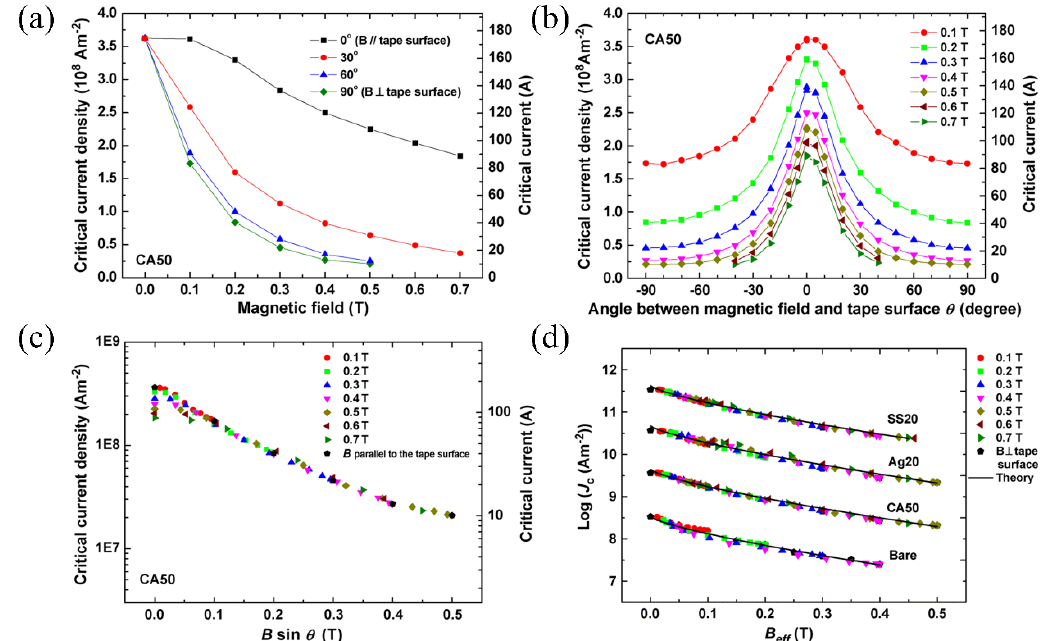
Figure 6. The electrical transport properties of the BSCCO tape at 77 K. ( a ) J c vs. B for different field orientations. ( b ) J c vs. θ at different applied magnetic fields. ( c ) I c vs. B sin θ of the tape. ( d ) J c vs. B eff for different tapes at 77 K. Reprinted with permission from Ref. [59]. Copyright 2011, IEEE-Inst